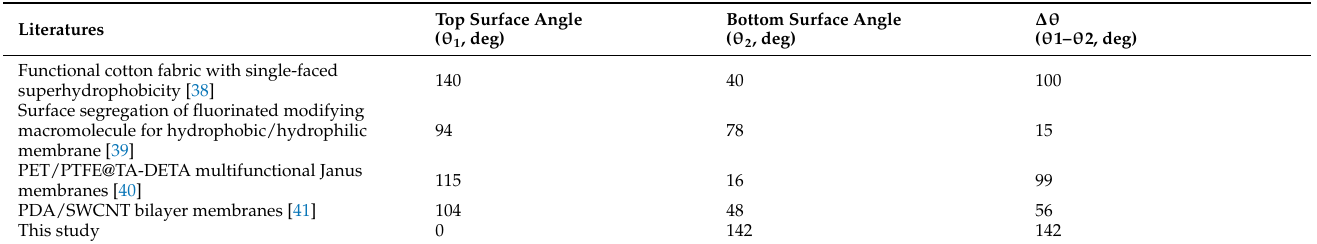
Figure 5. The surface wettability of membranes: ( a , b ) are the changes and comparisons of the WCA values in the air on the bottom (B) and top (T) surfaces of M0 and M1, respectively; ( c – g ) are the changes and comparisons of underwater OCA values of soybean oil, methylbenzene, n-hexadecane, silicone oil D5, and trichloromethane on the T surfaces of M0 and M1, respectively. Table 3. Comparison of the contact angle of the Janus membrane with other modified materials reported in